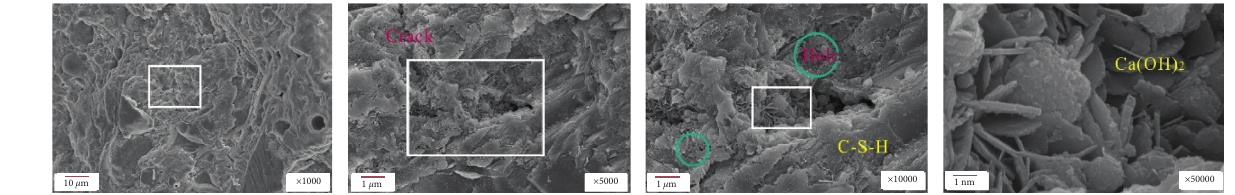
Figure 23: C-8 concrete microstructure before sample freeze-thaw.